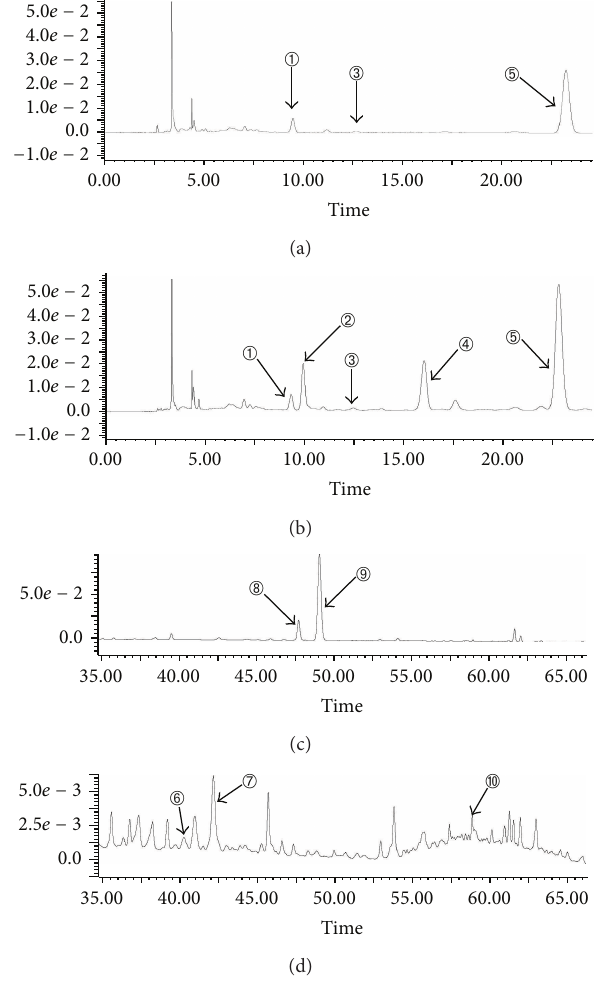
Figure 2: Partial chromatograms of (a), (c) raw Tianma extract, (b), (d) MWT Tianma